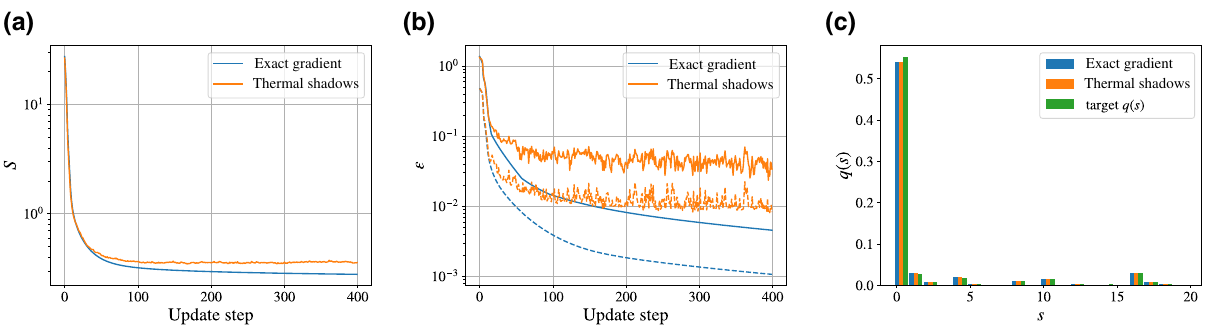
FIG. 4. (a) The quantum relative entropy of the salamander retina target state with respect to the eight-qubit fully connected QBM during training. The training is performed with both the exact gradient and the pure thermal-shadows algorithm. For both methods, the relative entropy decreases monotonically until a small finite value is reached. For these simulations, we use 10 000 thermal (Pauli) shadows, a QSP of degree 32, and a learning rate α = 0.2. (b) The maximum error (solid lines) in the predicted expectation values, ≡ max |(cid:3) O (cid:2) − (cid:3) O (cid:2) | , during training. For comparison, we also plot (cid:6) (cid:6) ρ θ η max j j j quantities also decrease and reach a finite value. The thermal-shadow method achieves a mean accuracy of order O ( 10 − 2 ) . This accuracy is expected to improve if we increase the number of thermal shadows used during training. (c) The empirical probability distribution q ( s ) of the target classical distribution obtained from the salamander ganglion cells data set (green) versus the distribution diag (ρ θ ) obtained from the trained QBM. For visualization purposes, we only plot the probabilities of the first 20 out of the total 2 8 bit strings s . The distribution of the trained QBMs matches the target q ( s )